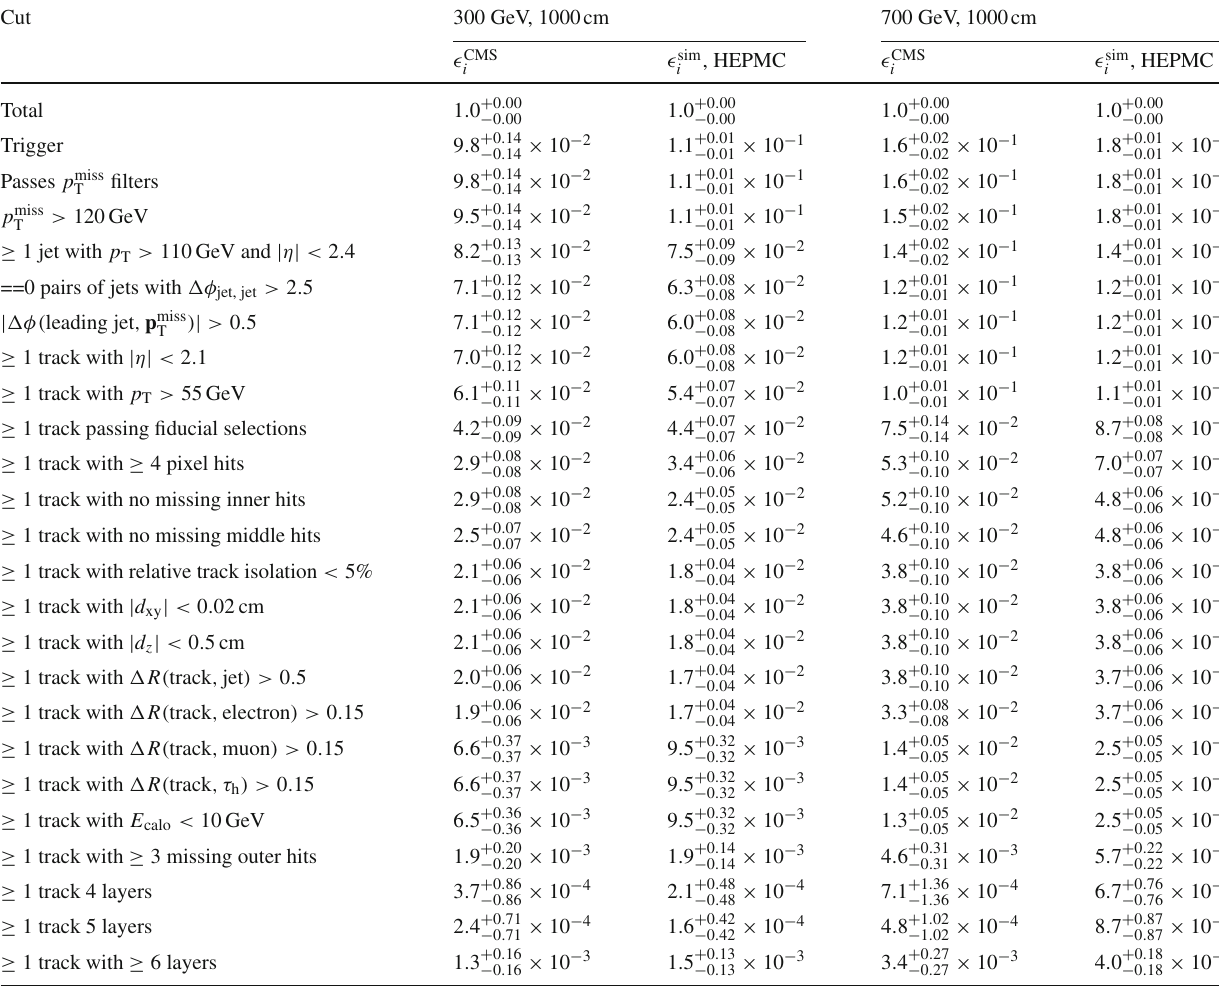
Table 10 Cutflow comparison for signal region 2018A and decay length 1000cm, for 300 GeV and 700 GeV winos